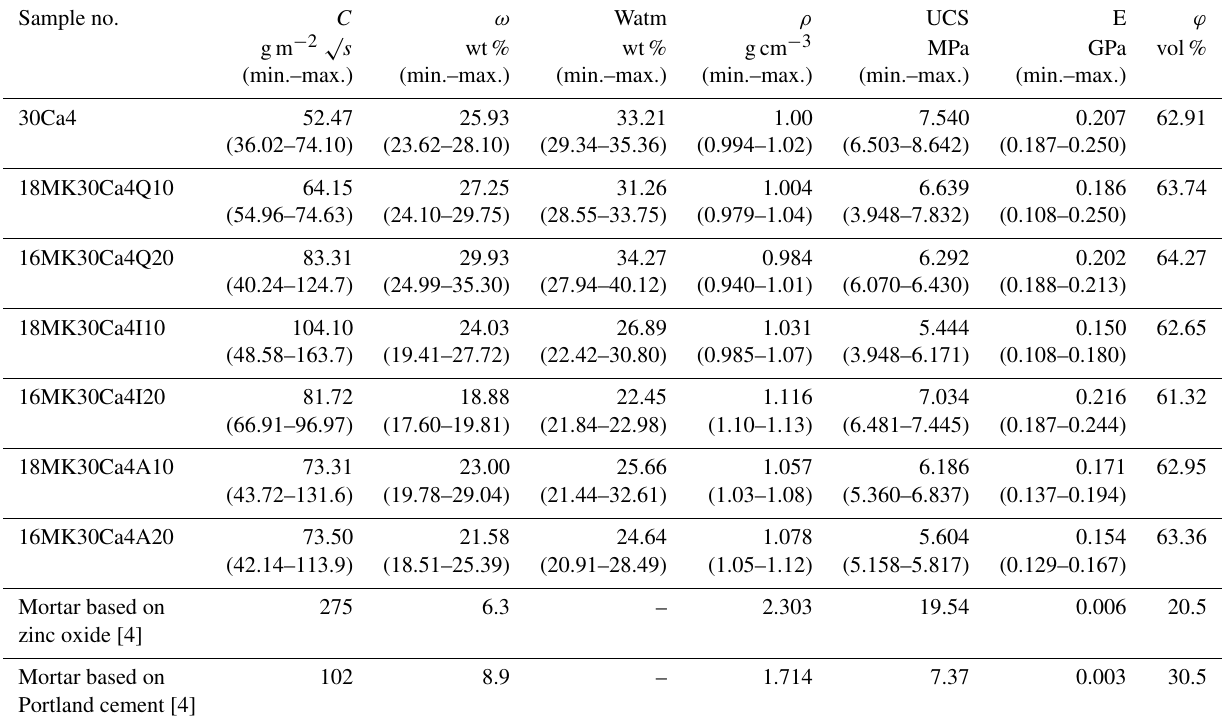
Table 3. Physico-mechanical properties of Batch 2. C: capillary coefficient; ω : capillary moisture content; W atm : water absorption by im- mersion, ρ : bulk density; UCS: uniaxial compressive strength; E: Young’s modulus; ϕ : open porosity, by MIP. Sample